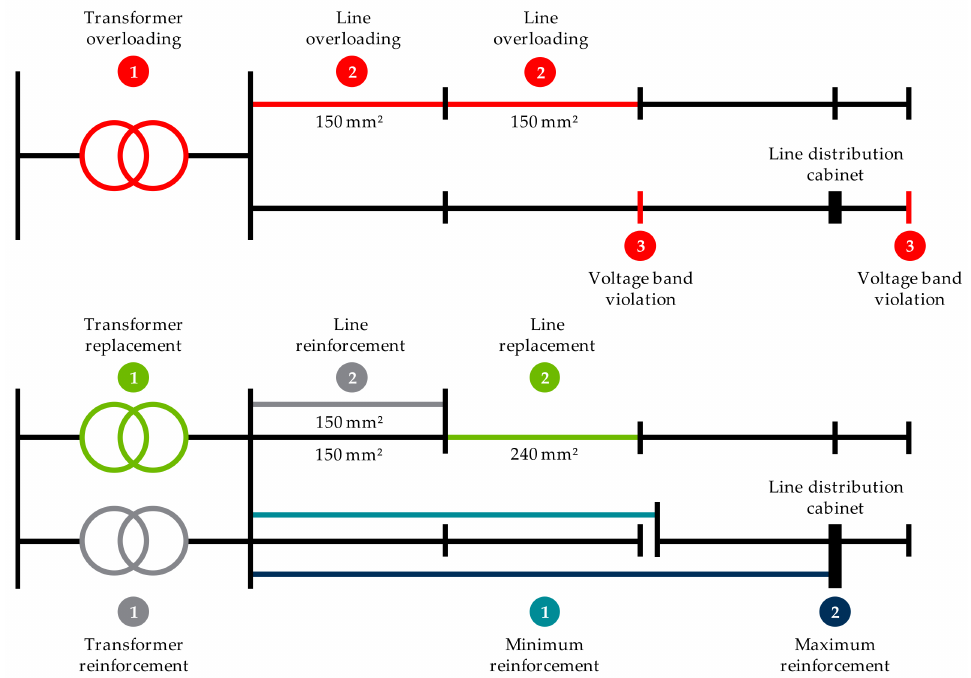
Figure 9. Conventional planning measures in the low-voltage